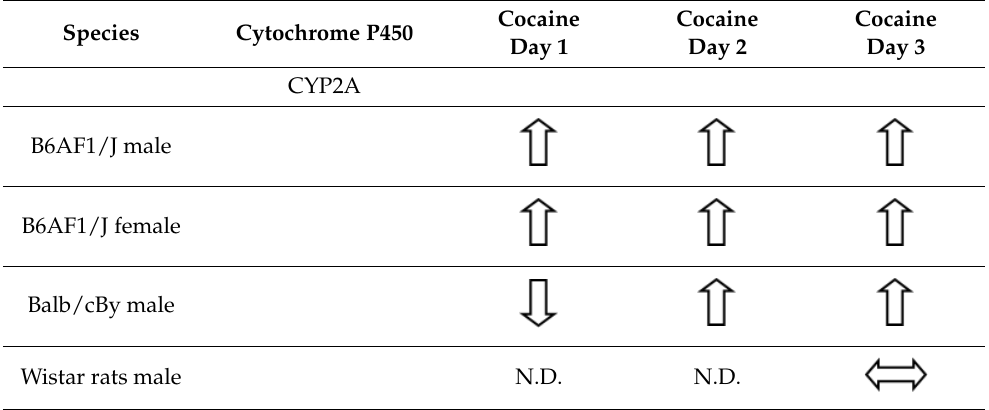
Table 3. The effect of repeated administrations of cocaine (30 mg/kg ip. for 3 days) on protein levels and activity of selected cytochrome P450 (CYP) enzymes in animal livers.